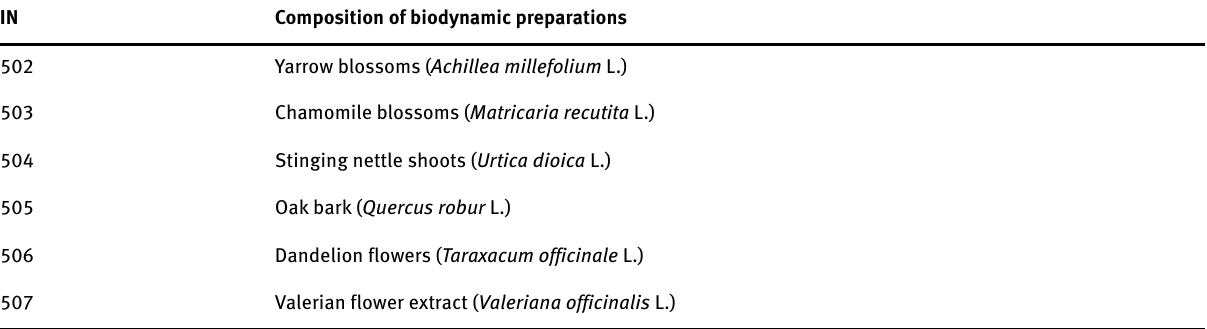
Table 1: Biodynamic preparations identification number (IN) and components descriptions IN Composition of biodynamic